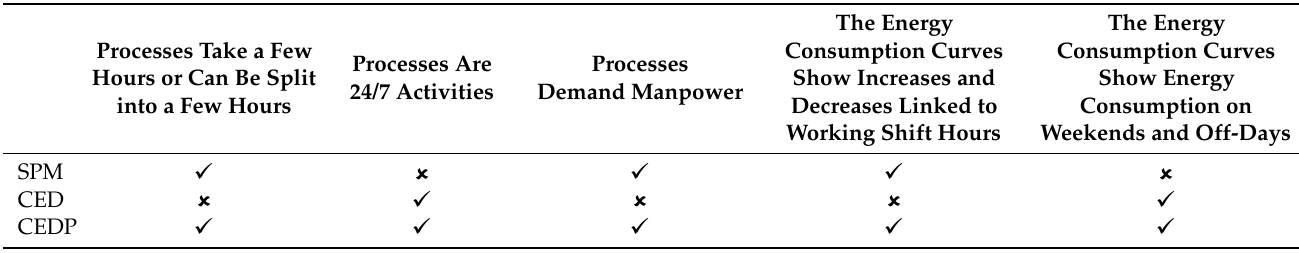
Table 2. Industry group properties.